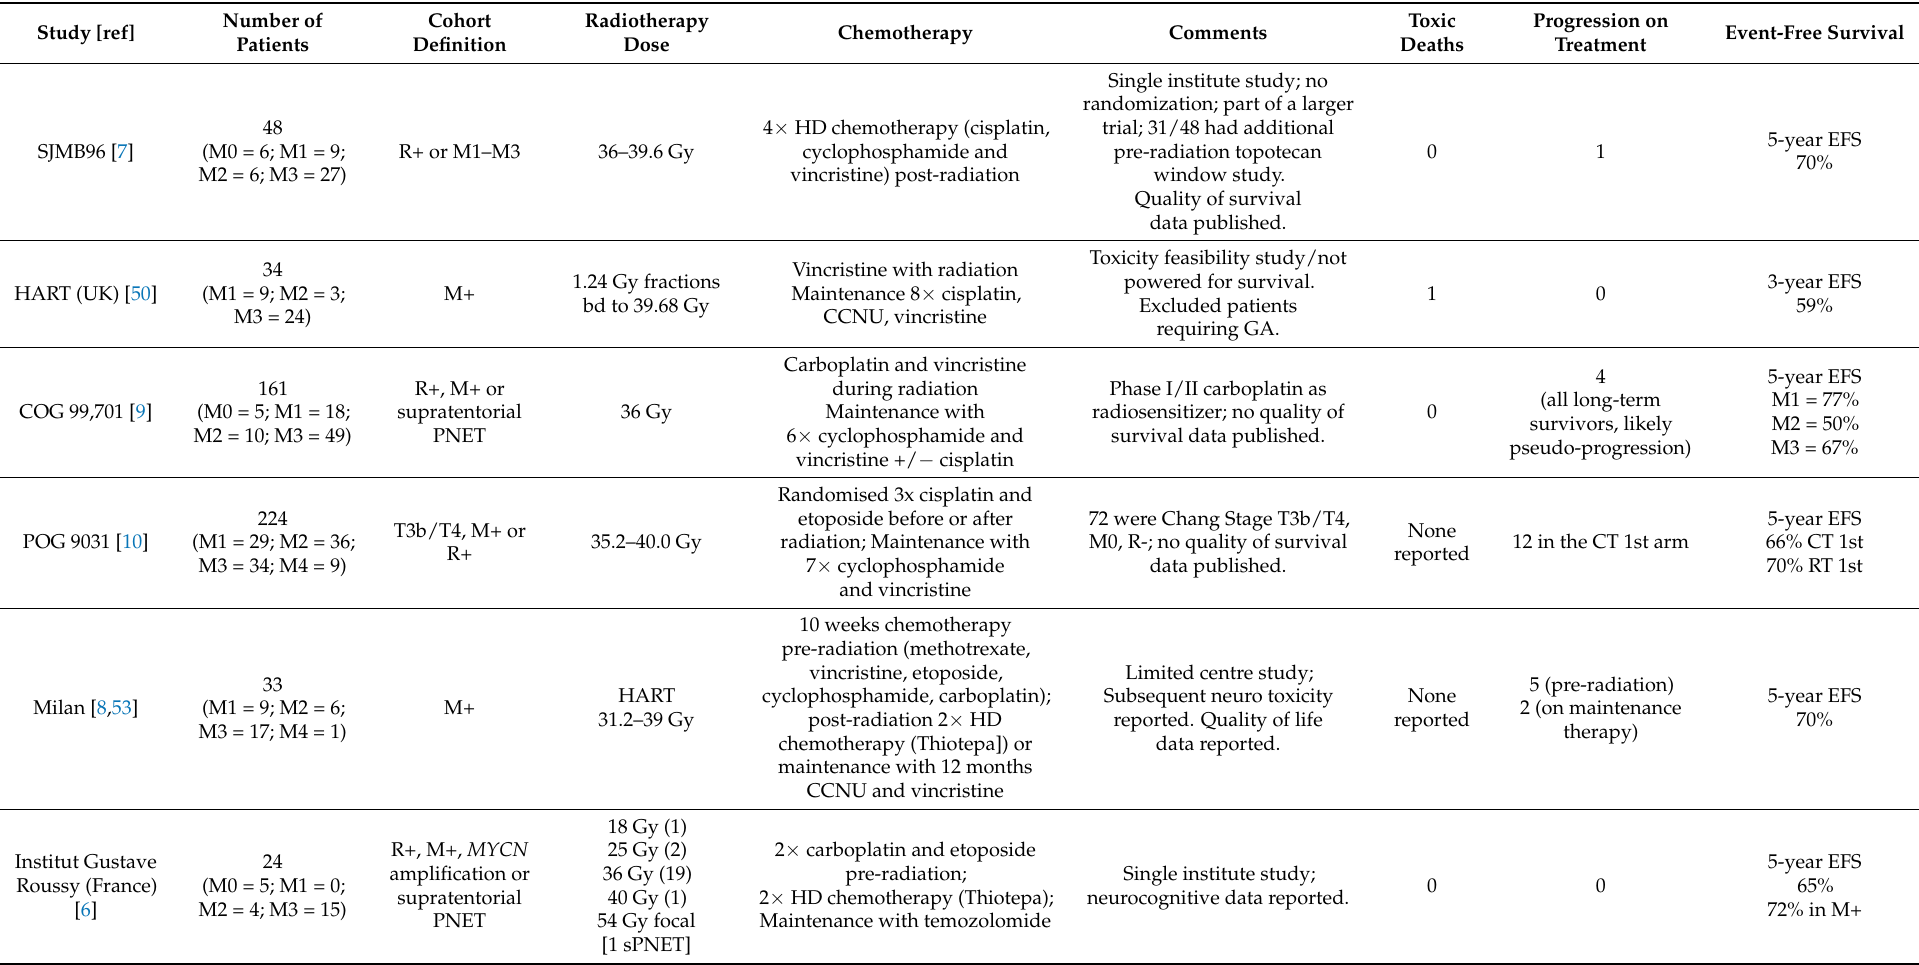
Table 2. Summary of clinical trials in high-risk medulloblastoma. R+ = Residual disease > 1.5 cm 2 ; M+ = metastatic disease; M1–3 = Chang metastatic